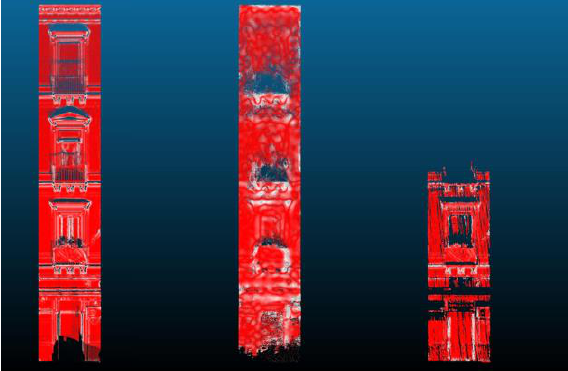
Figure 10 . Curvature analysis between (from left to right) TLS, SFM, SLAM scans.